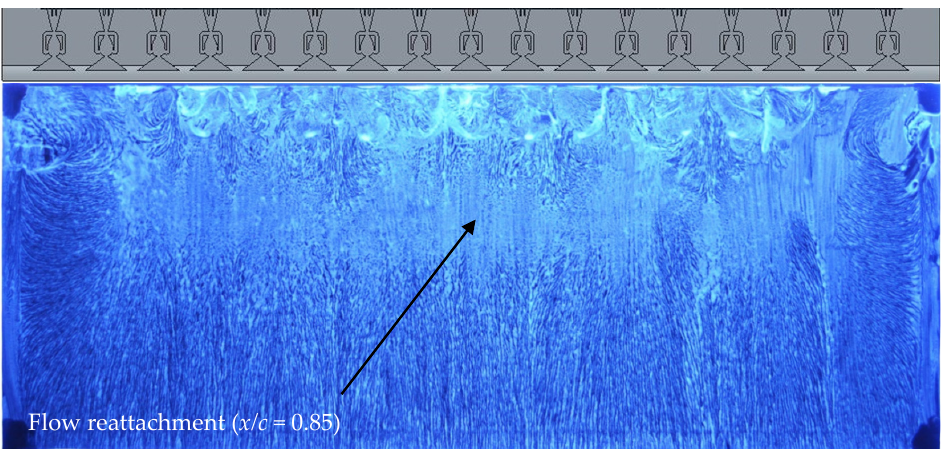
Figure 7. Surface oilflow visualization for the fluidic oscillator flow control case with C µ =